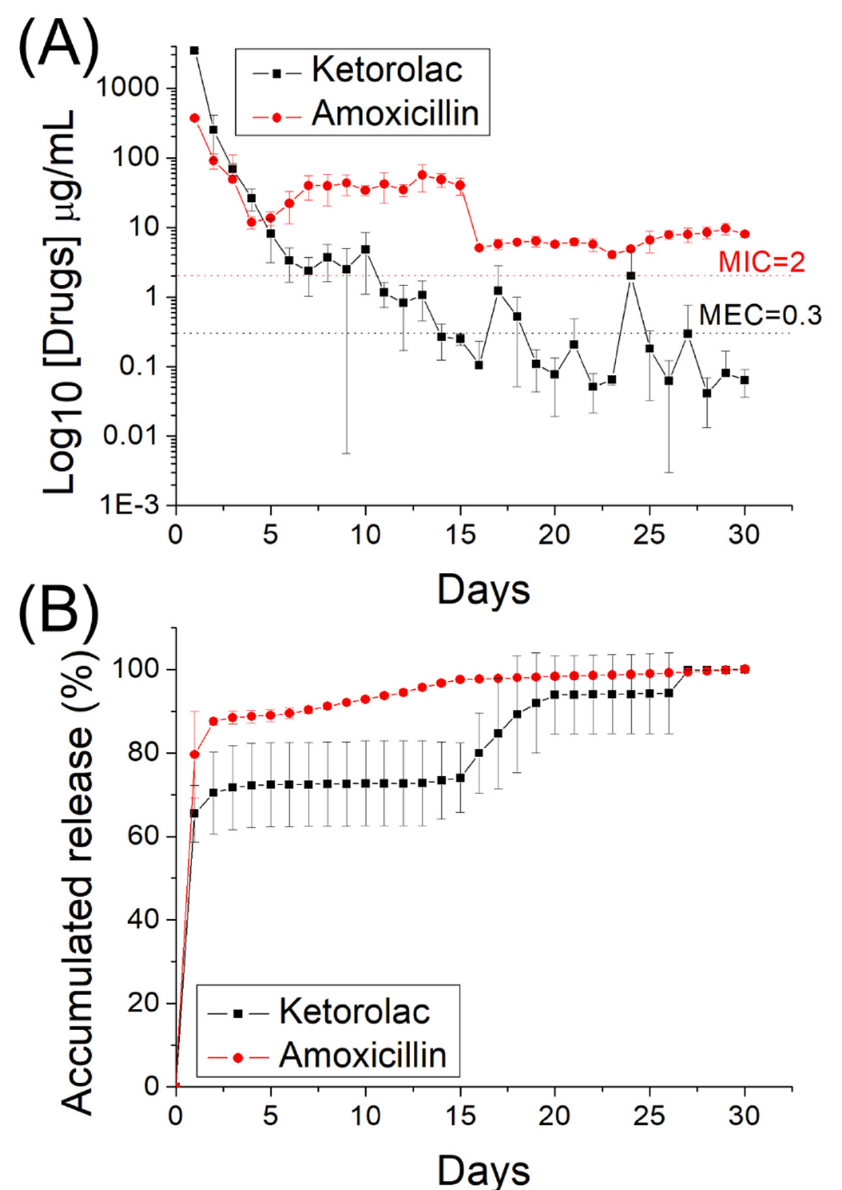
Figure 8. In vitro ( A ) daily and ( B ) cumulative release of ketorolac and amoxicillin from the sheath– core-structured nanofibers. The minimum effective concentration of ketorolac was 0.3 μ g/mL, and the minimum inhibitory concentration of amoxicillin was 2 μ g/mL [36,37].